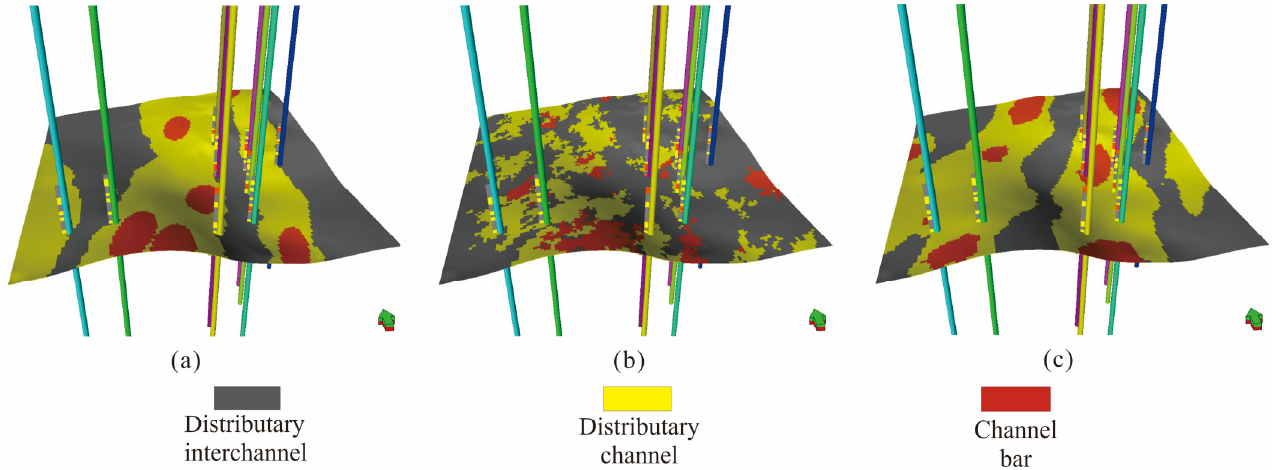
Figure 12. Comparison of facies types of the same layer between the well data and the models generated by the three methods. ( a ) Object-based simulation result; ( b ) SIS result; ( c ) MPS results based on 2D TIs.